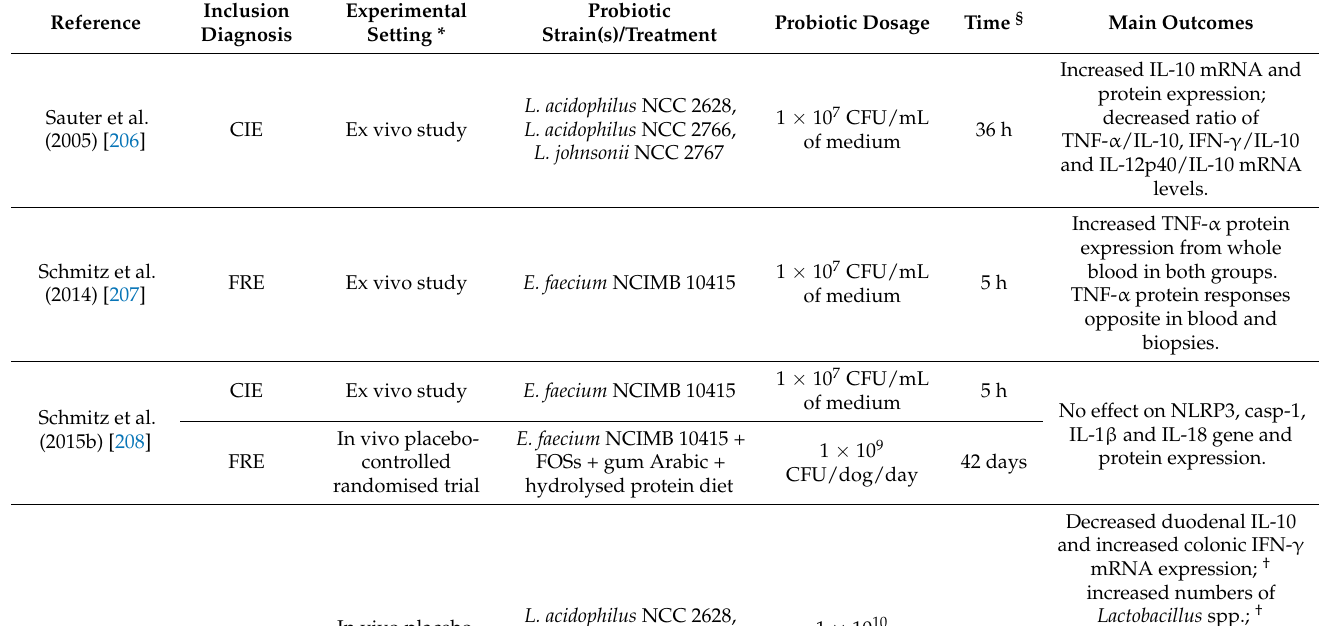
Table 1. Specifications of selected studies evaluating the efficacy of probiotic/synbiotic treatment in dogs with